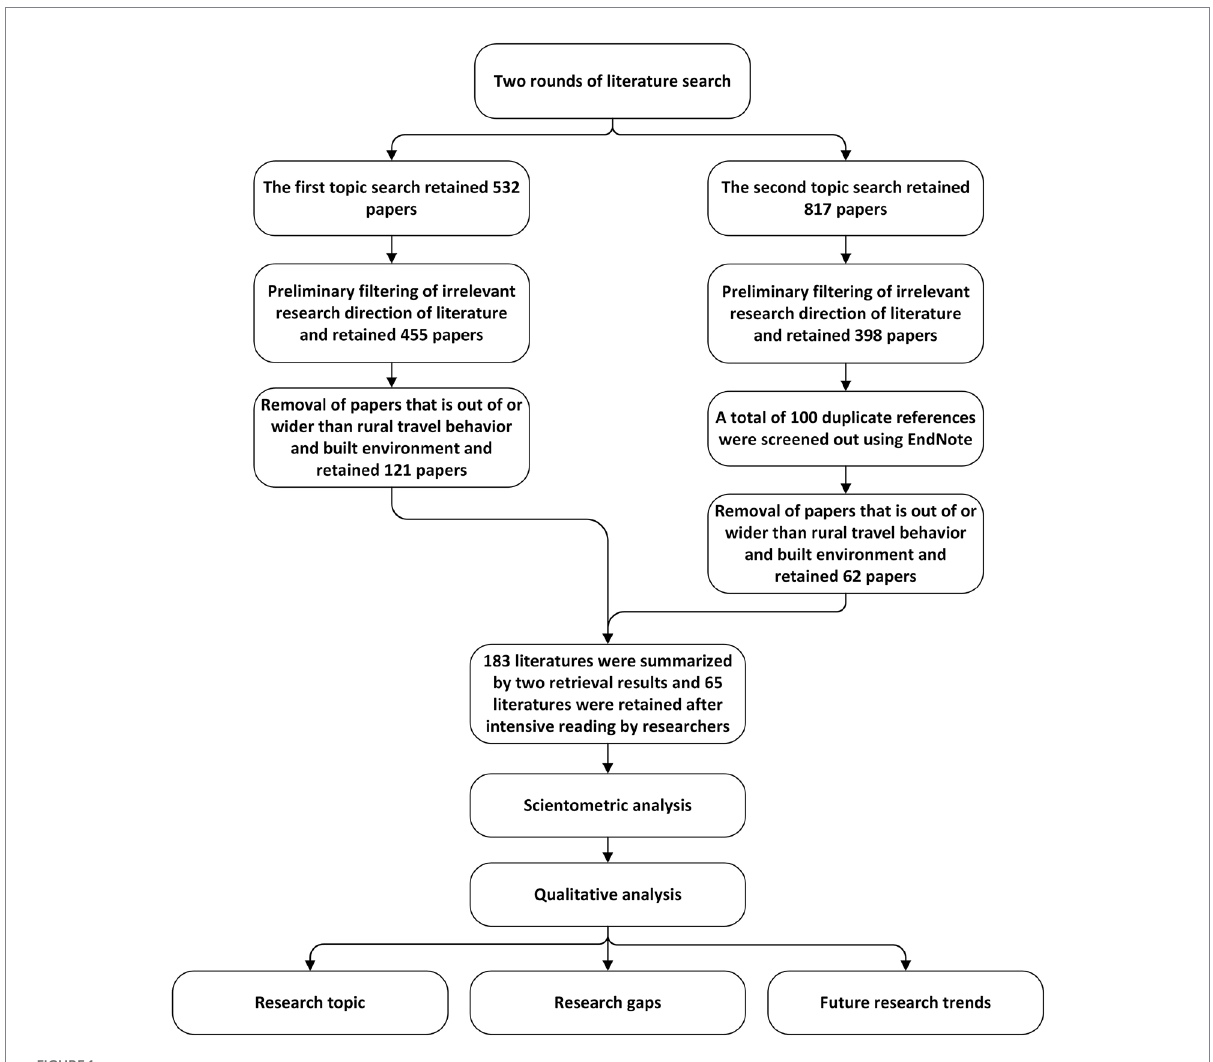
FIGURE 1 Flow chart of scientific analysis of literature on this research